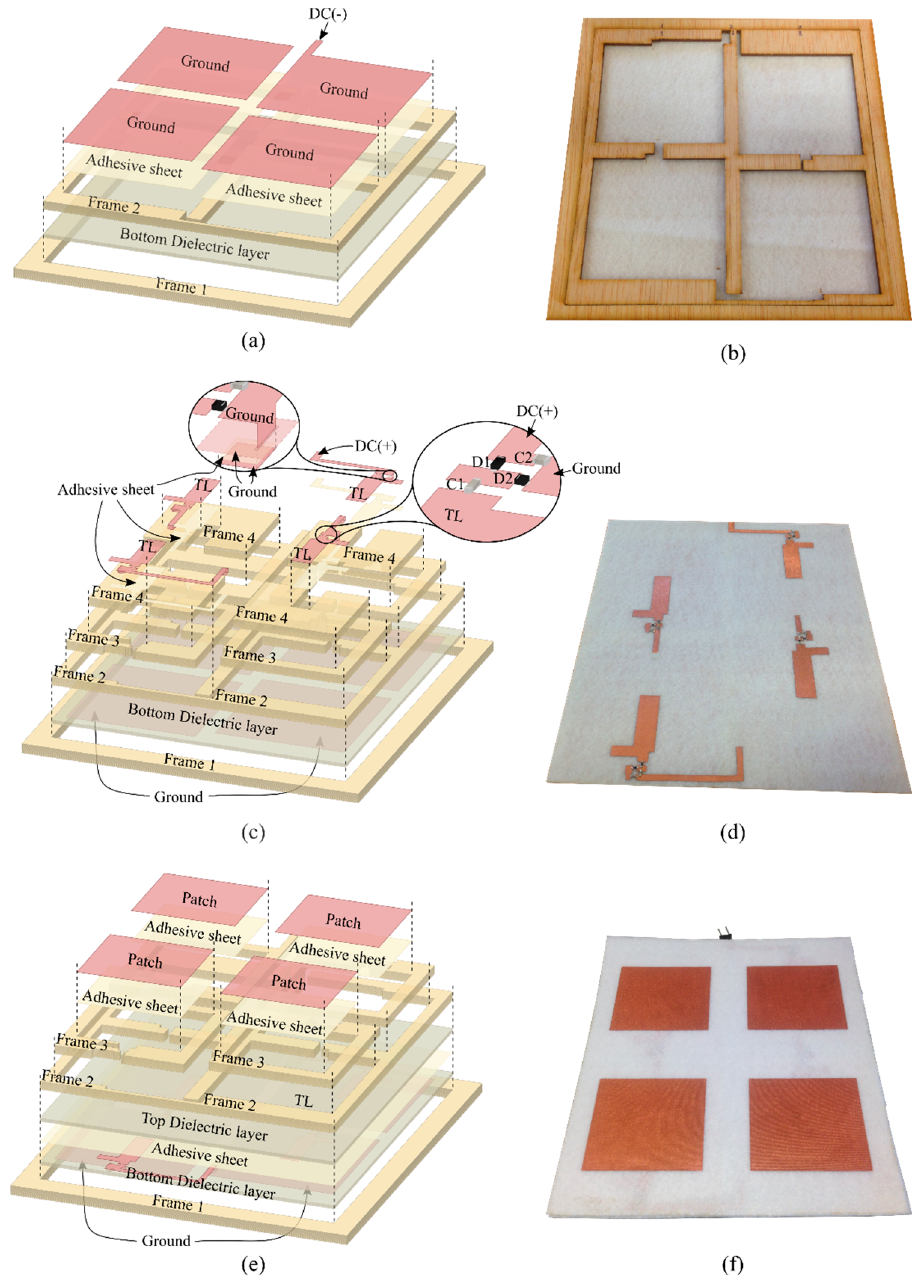
Figure 16. Rectenna construction process. For clarity, all the antenna layers have been separated and labeled at the side.